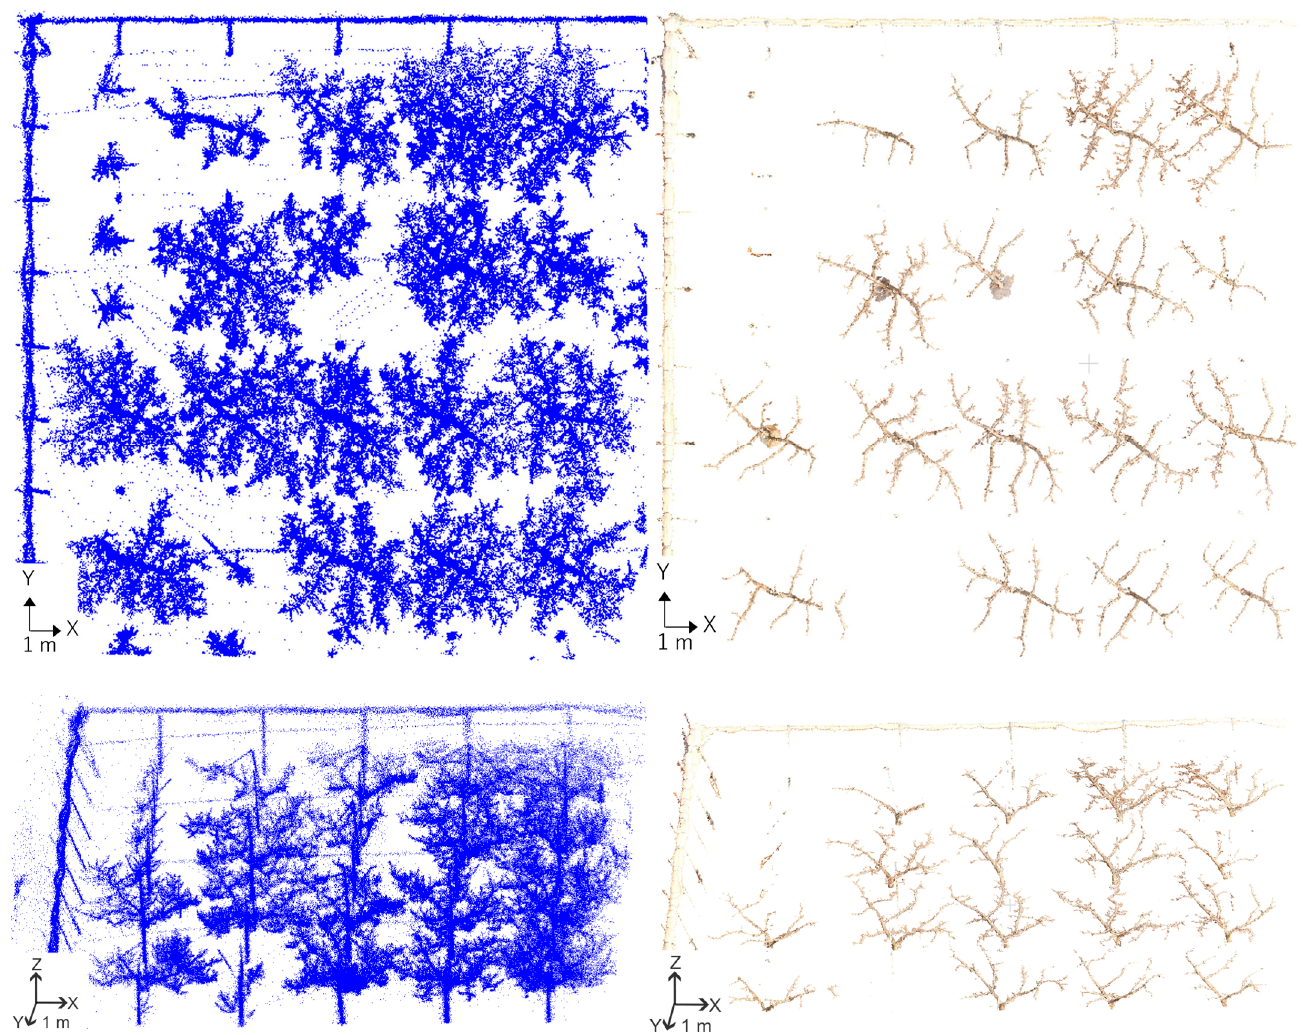
Figure 6. Comparison of the point cloud models without ground surface made using the data from 4 February 2022: top view of the 3D lidar SLAM on the left top , the 45 degree viewing angle of the 3D lidar SLAM on the left bottom , the top view of the UAV-SfM on the right top , and the 45-degree viewing angle of the UAV-SfM on the left bottom .